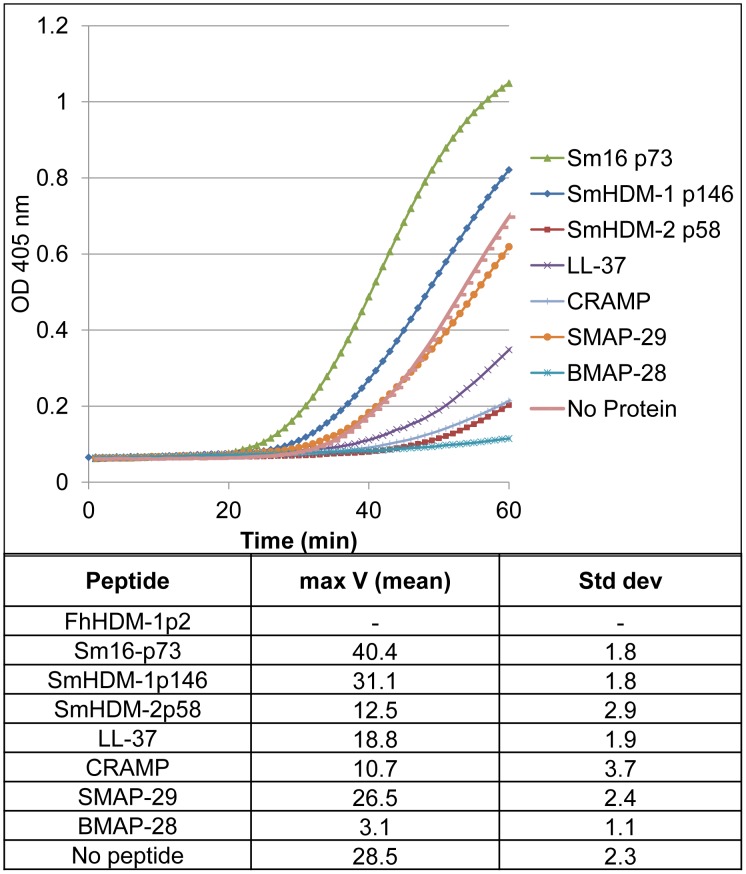
Mammalian and helminth cathelicidin-like peptides display varied LPS binding capacity.25 µl of peptide (250 pmol/ml) was incubated with 25 µl of LPS from E. coli O113:H10 (1 EU/ml) for 30 min at 37°C to allow the interaction between both molecules. Chromo-LAL reagent was then added and the liberation of ρ-nitroaniline was monitored every 60 sec at 405 nm. The top panel is a representative of the curves obtained for each peptide. The data presented in the Table is the mean of three replicates from two separate experiments. The extent of binding of peptide to LPS prior to adding the mixture to the Chromo-LAL is reflected in the reduced rate of cleavage of the substrates and a corresponding inability of the reaction to reach maximum velocity (Vmax).